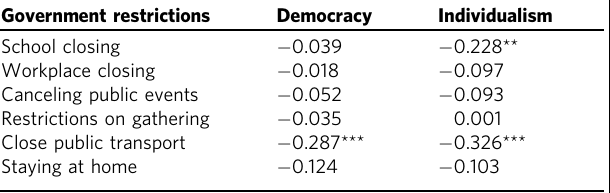
Table 3 Pearson ’ s correlation of democracy and individualism with stringency speed of speci fi c